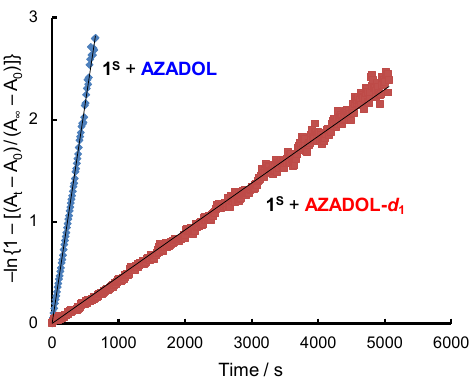
Figure 4. Pseudo first-order analyses of the reaction with AZADOL and AZADOL- d 1 .